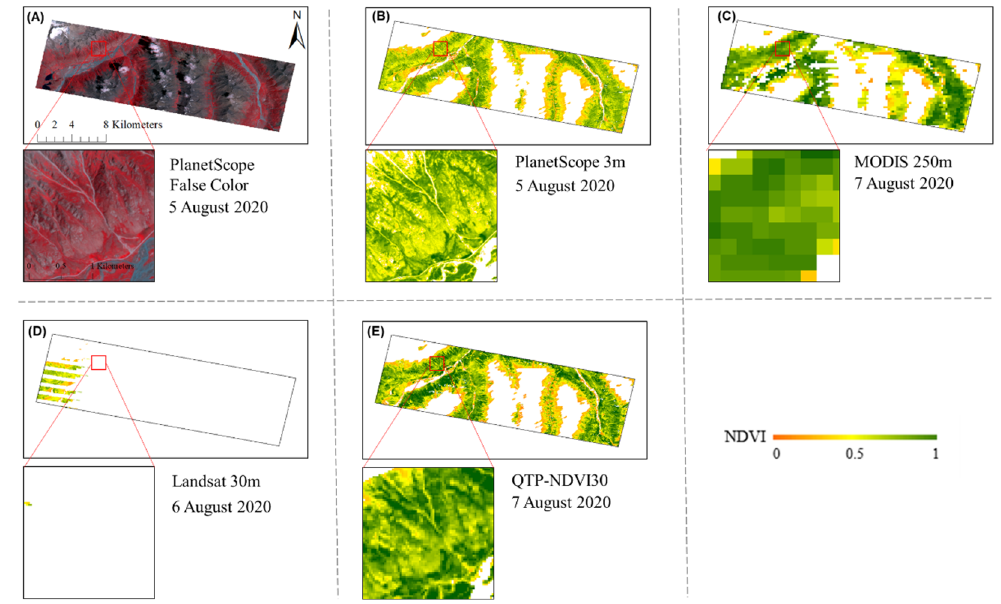
Figure 8. The same as Figure 7 but for the B-8 area.